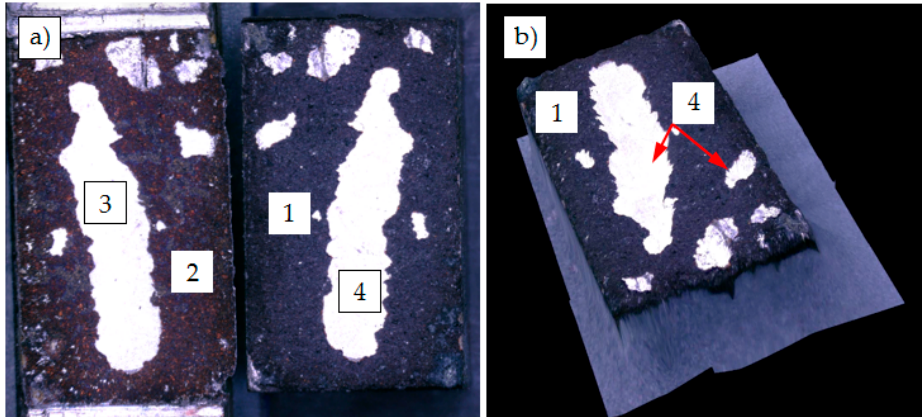
Figure 13. Mixed solder/intermediate layer fracture under shear test (sample no. 5) ( a ) and 3D view of graphite composite fracture ( b ); 1—graphite composite; 2—Cu coating detached from the graphite composite; 3—solder; 4—Cu coating detached from the solder.